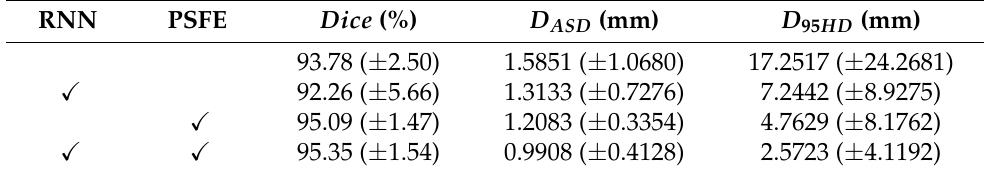
Table 2. Ablation analysis on different modules of the RNN and PSFE.